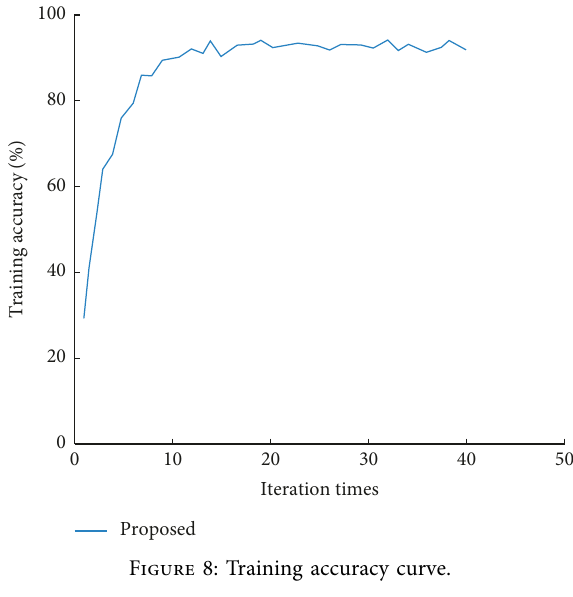
Figure 8: Training accuracy curve.